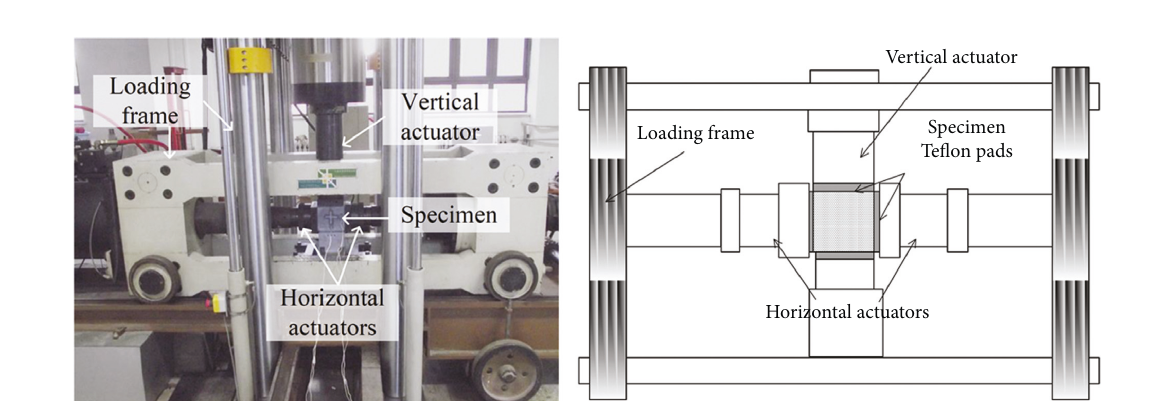
Figure 1: Biaxial test setup of RPC specimens.